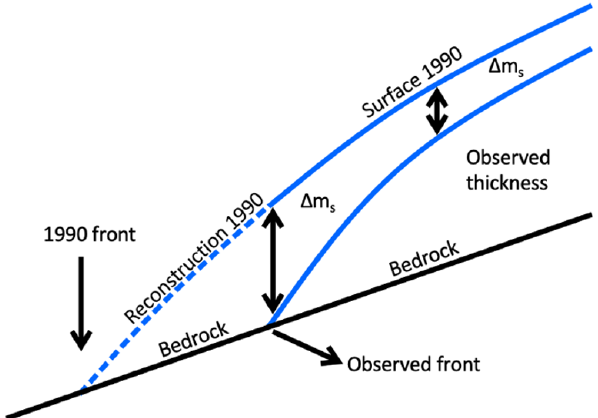
Figure 3. Reconstruction of the 1990 geometry from a combina- tion of modelling the cumulative surface mass balance ( (cid:49)m s ) and